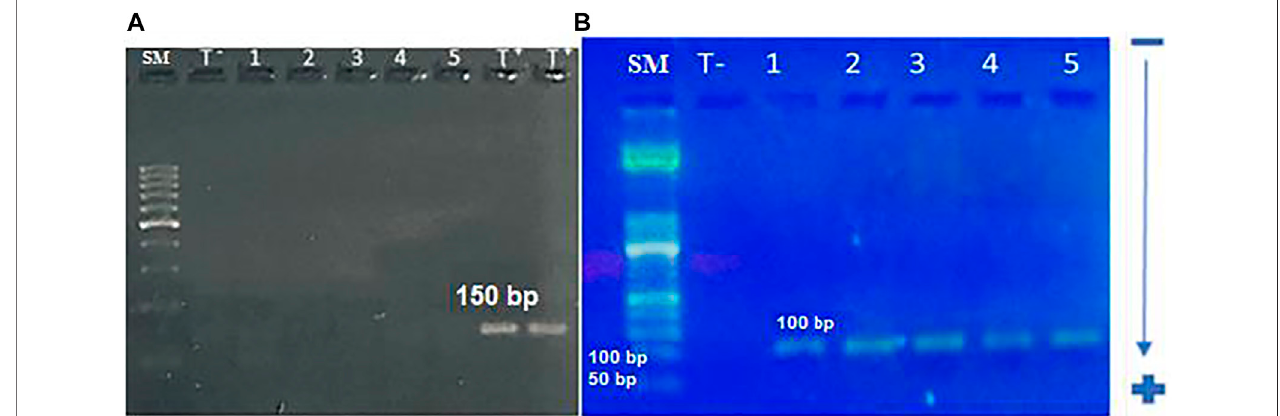
FIGURE2| electrophoreticpro fi leofUL55geneampli fi cationbynested-PCR; (A) :Electrophoreticpro fi leofUL55geneampli fi cationusingthe fi rstsetofprimers.A singlebandiscorrespondingtotheexpectedsize(150 bp).SM:100 bpsizemarker,T − :negativecontrol,1 – 5:studiedsamples,T+:positivecontrol (B) :electrophoretic pro fi le of UL55 gene ampli fi cation using the second set of primers. A single band is corresponding to the expected size of 100 bp. SM: 50 bp size marker, T − : negative control, 1 – 4: studied samples, 5: positive control.